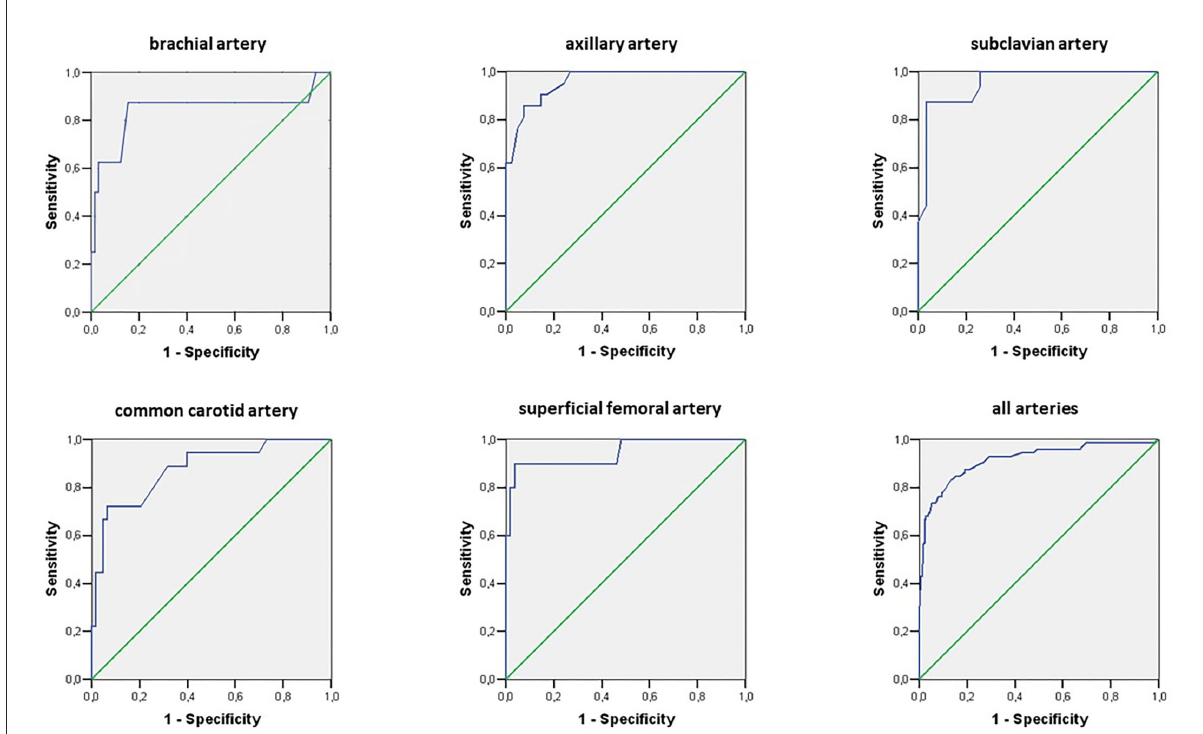
FIGURE2 Receiver operating characteristic (ROC) curves for cut-off values of intima-media thickness (IMT) depicting vasculitis in patients with giant cell arteritis. The maximal IMT value from bilateral color duplex ultrasonography measurements was